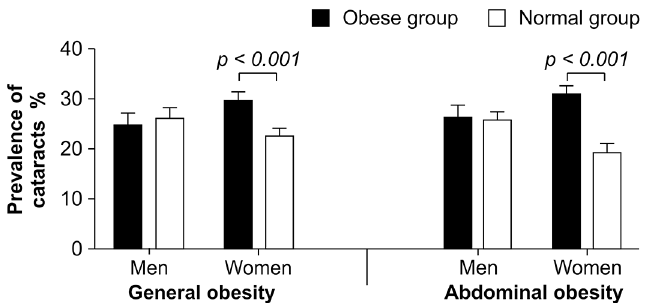
Fig 2. A comparison of the prevalence of cataracts according to age group and type of obesity. The prevalence of cataracts was significantly higher among middle-aged women in the generally obese group (29.5% vs. 22.6%) and the abdominally obese group (30.8% vs. 19.3%), compared with their non-obese counterparts ( P < 0.001 for both types of obesity). General obesity = body mass index (cid:1) 25 kg/m 2 ; Abdominal obesity = waist circumference (cid:1) 90 cm for men, (cid:1) 80 cm for